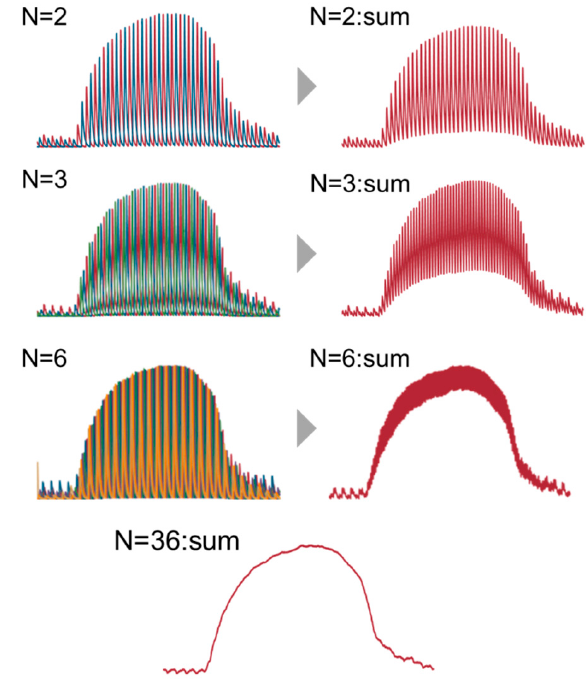
Figure 3. The method for obtaining a continuous spectrum from pulsed spectra.